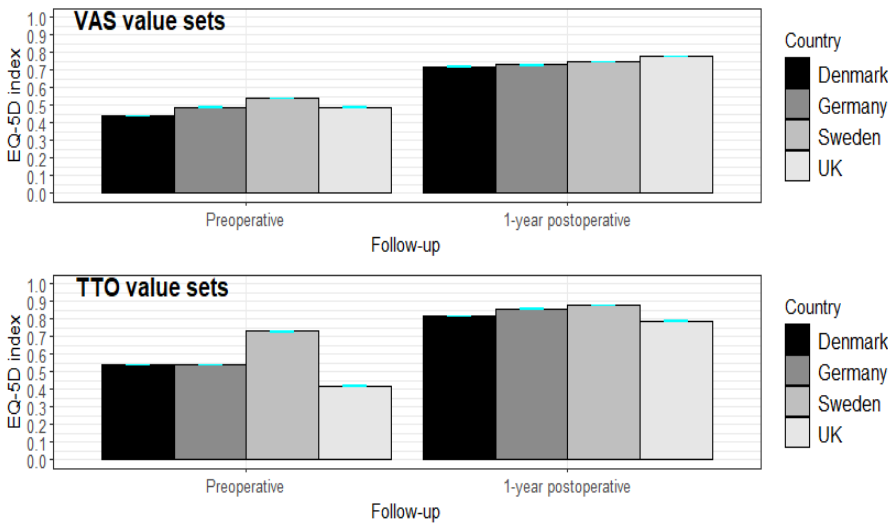
Figure 1. Mean EQ-5D-3L indices (95% CI) among VAS and TTO value sets among THR patients by follow-up (preoperative and 1-year postoperative) ( n = 73,523).